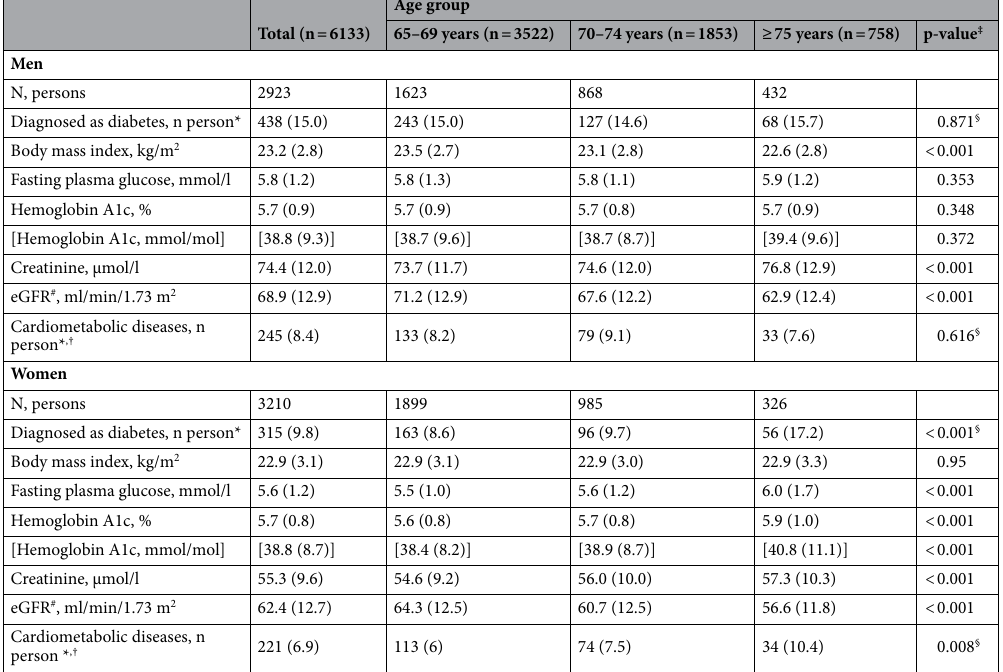
Table 1. Basic characteristics of the 6133 subjects according to the three age-groups with a normal creatinine level (< 115 μmol/l for men and < 106 μmol/l for women). Data are expressed as mean (standard deviation) or * number (%). eGFR estimated glomerular filtration rate. † Number of persons who have a history of at least one chronic disease, including hypertension, hyperlipidaemia, cerebral stroke, myocardial infarction, and angina pectoris based on self-reporting. ‡ p-value was calculated using one-way analysis of variance. § p-value was calculated using the χ 2 test. # eGFR was calculated by following equations: 194 × serum creatinine −1.094 × age −0.287 for men and 194 × serum creatinine −1.094 × age −0.287 × 0.739 for women, and adjusted by body-surface